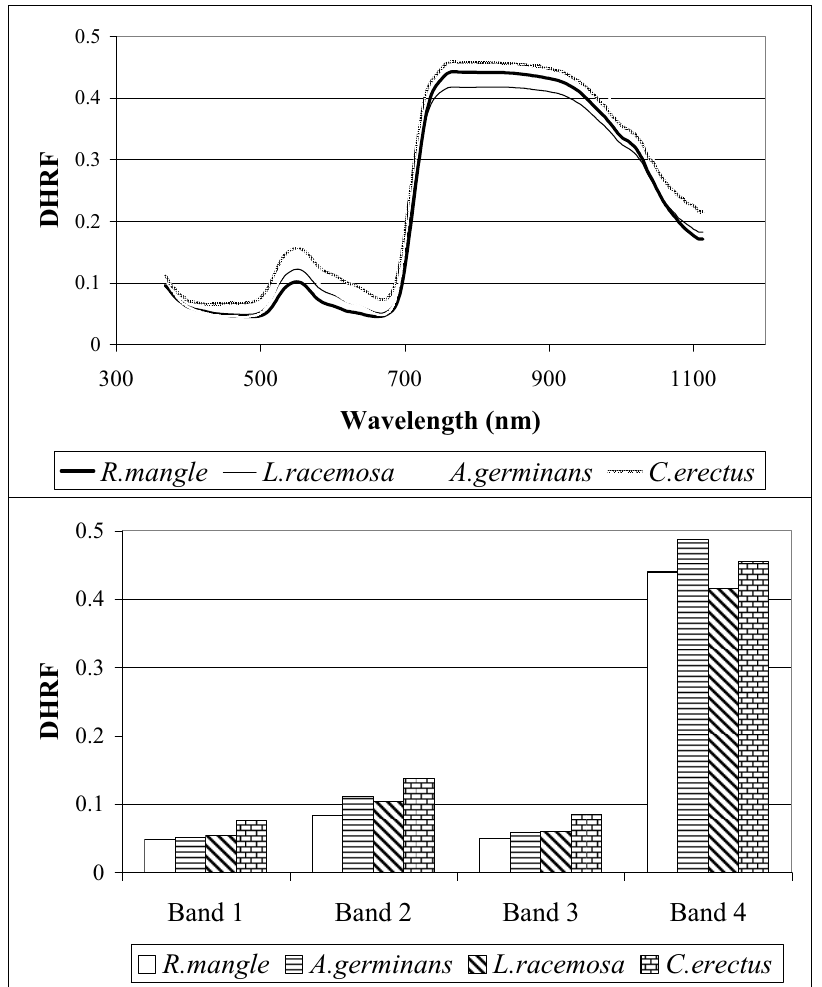
Fig. 2 – Complete HRF spectra and HRF for each spectral band of mangrove